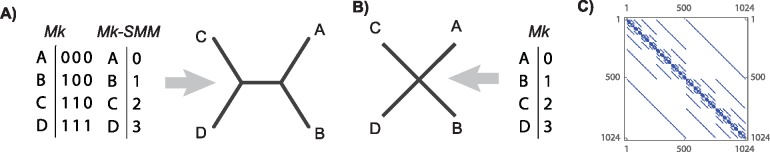
Character amalgamation. a) Amalgamation of the three two-state characters evolving under Mk model results in one four-state character evolving under Mk-SMM (the amalgamation of the three two-state characters results in the eight-state rate matrix for Mk-SMM; in the given set of species only four states {0, 1, 2, 3} are observed, therefore, the remaining four states are omitted). The phylogenetic inference using these two data sets yields the identical and resolved topology. b) If amalgamation of the three two-state characters into one four-state character is done without appropriately structuring the rate matrix (i.e., using four-state Mk model) then the topology is unresolved. c) The amalgamated rate matrix (1024 states) of ten two-state characters; the zero cells (without rate values) of the matrix are shown in white.